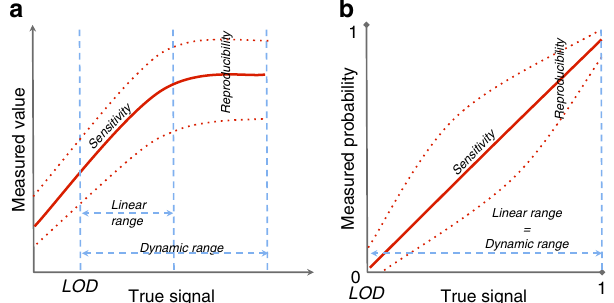
Fig. 1 Analytical FoM related to the calibration lines. a Calibration line for omics measuring the levels of the target features (MS platforms and gene- based sequencing platforms). b Calibration line for omics not measuring concentrations but fi nding genomic regions, where a biological event occurs (region-based sequencing